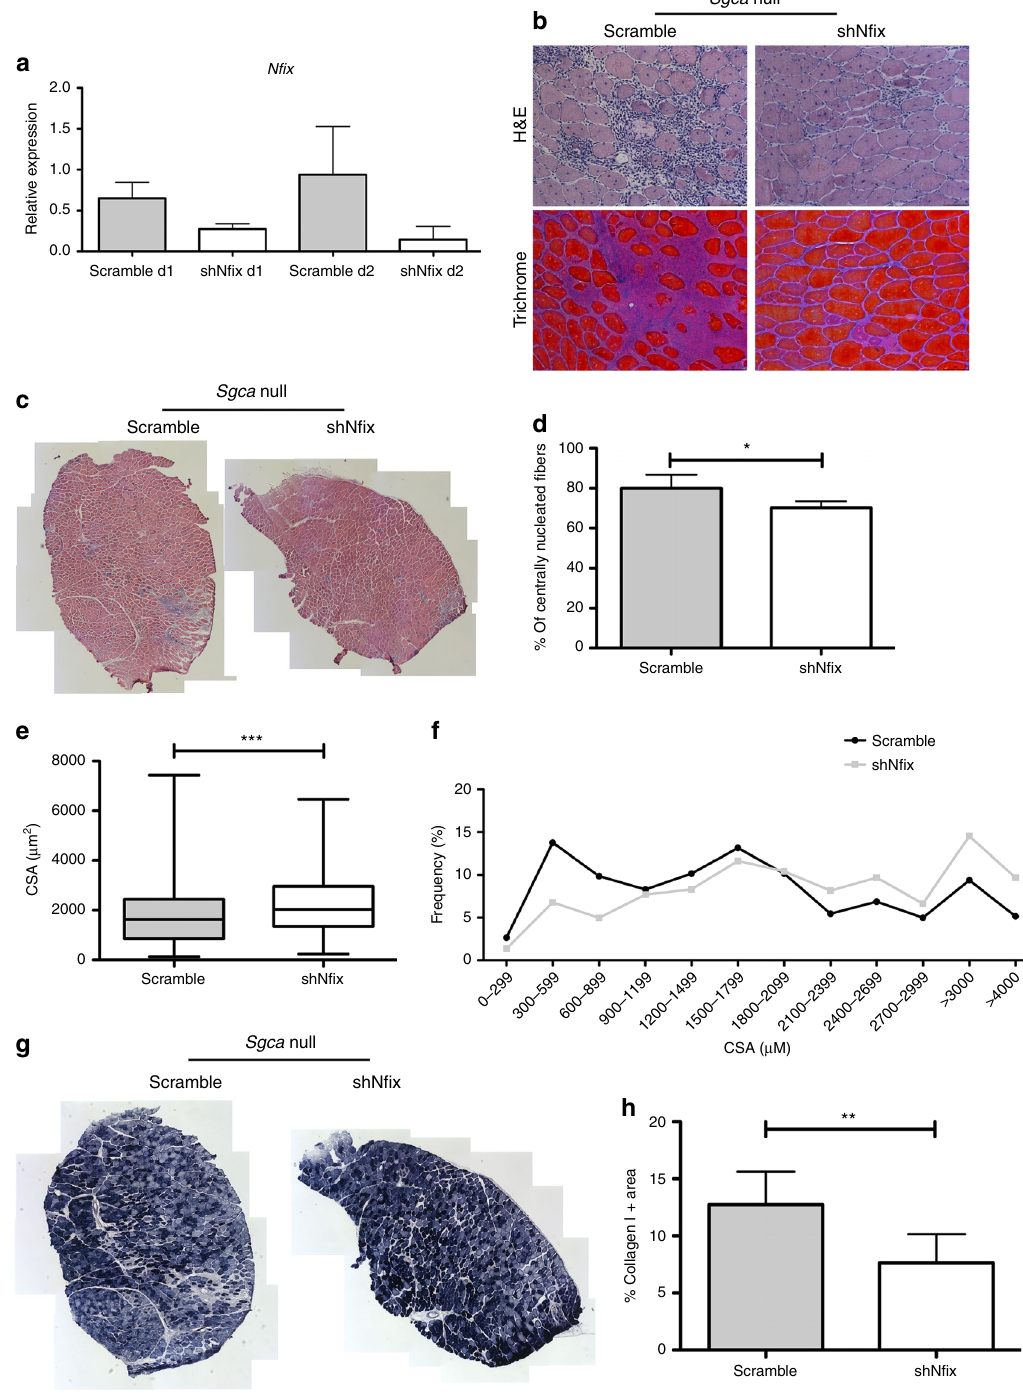
Fig. 7 Silencing N fi x in adult Sgca null mice morphologically rescues the dystrophic pathology. a Real-time PCR analysis of N fi x expression on Sgca null muscles electroporated with scramble or shN fi x plasmids after 1 or 2 days (d) from electroporation. N = 2 for each group. Mean ± SD. b Hematoxylin and eosin (H&E) and Milligan ’ s trichrome staining of tibialis anterior muscles from Sgca null mice electroporated with scramble or shN fi x plasmids; N = 9 mice. Scale bar 75 μ m. c Entire tibialis anterior muscle section reconstructions of Sgca null mice electroporated with scramble or shN fi x plasmids; N = 9 mice. d Percentage of centrally nucleated myo fi bers in tibialis anterior muscle sections from Sgca null mice electroporated with scramble or shN fi x plasmids. N = 5 mice. Mean ± SD; t test, * P < 0.05. e , f Myo fi ber cross-sectional area distribution in Sgca null mice electroporated with scramble or shN fi x plasmids; N = 639 fi bers for scramble and 661 for shN fi x. Mean ± whiskers from min to max; t test, *** P < 0.001. g SDH staining of Sgca null tibialis anterior muscles electroporated with scramble or shN fi x vectors; N = 4 mice. h Quanti fi cation of collagen I positive areas in Sgca null tibialis anterior muscles electroporated with scramble ( N = 9) or shN fi x ( N = 9) plasmids. Mean ± SD; t test, ** P <